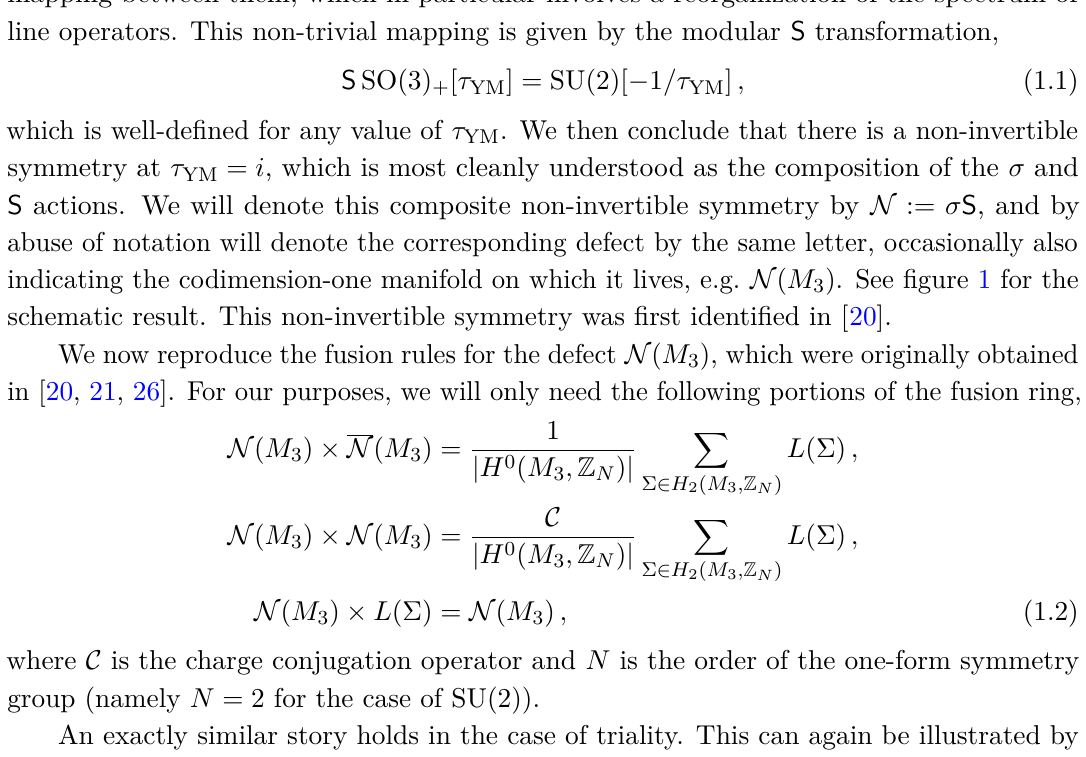
one-form symmetry, together 2